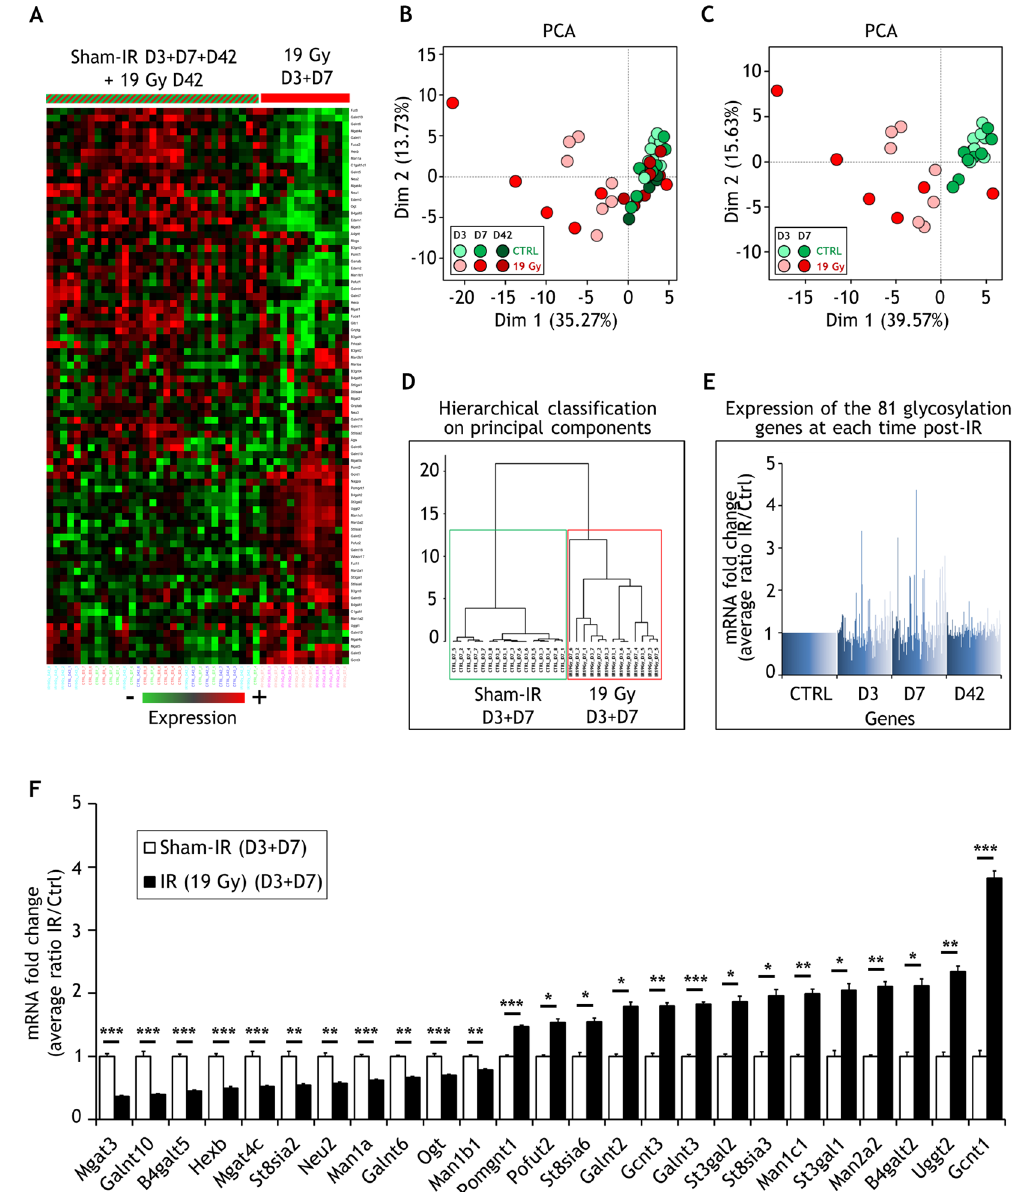
Figure 6. Glycosylation transcriptome analysis of irradiated C57BL/6 small intestine. ( A ) Heat map of the hierarchical clustering of all mouse samples based on measured gene expression values. ( B ) Principal component analysis of all mouse samples based on measured gene expression values. ( C ) Principal component analysis of D3 and D7 mouse samples based on measured gene expression values. ( D ) Hierarchical classification on principal components from the PCA of D3 and D7 mouse samples. ( E ) Fold change expression (sham-IR vs 19 Gy) of the measured glycosylation genes at each time post-IR. ( F ) Fold changes of statistically differentially expressed mRNA (25 genes) between sham- and 19 Gy-irradiated C57BL/6 samples (threshold 1.5 Sham-IR vs 19 Gy at D3 or D7) (mean + / − SEM). The experiment was performed once with n = 8 mice for sham- irradiation at day 3, n = 7 mice for 19 Gy-irradiation at day 3, n = 8 mice for sham-irradiation at day 7, n = 6 mice for 19 Gy-irradiation at day 7, n = 7 mice for sham-irradiation at day 42, and n = 8 mice for 19 Gy- irradiation at day 42. The histogram (F) was built by grouping the data from D3 and D7, with final n = 16 for sham-irradiated mice and n = 13 for 19 Gy-irradiated mice. Data were analyzed by a two-tailed t -test. Adjusted p -values (Benjamini-Hochberg procedure) (Ctrl vs IR): * p < 0.05; ** p < 0.01; *** p < 0.001. Ct, Δ Ct, 2 −Δ Ct , fold changes, SD, SEM and p -values are displayed in the Supplementary Table